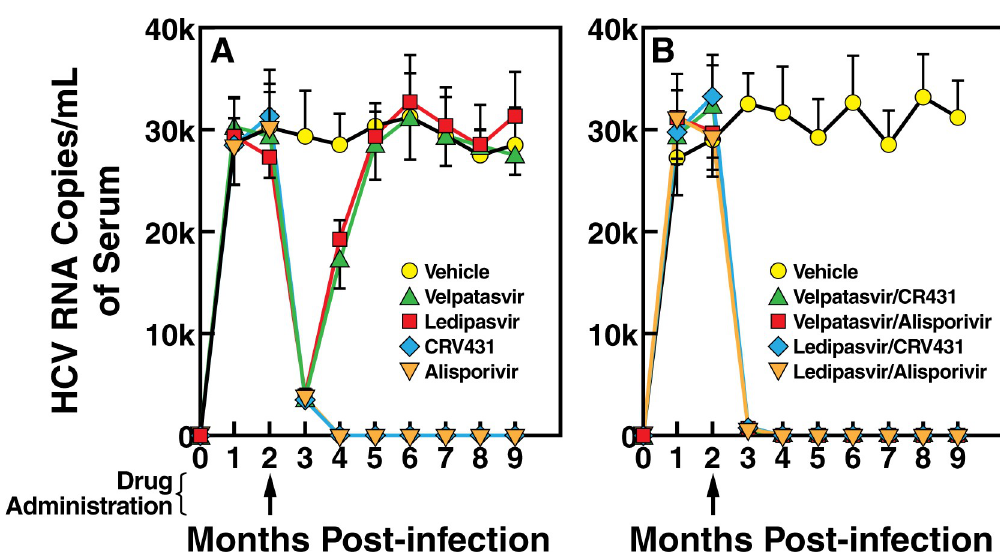
Fig 4. HCV rebound analysis in humanized-liver chimeric mice. MUP-uPA-SCID-Beige mice implanted with human hepatocytes were infected i.v. with plasma from HCV-infected chimpanzee (100 infectious doses (CID 50 )/mL of GT1a, GT2a, GT3a and GT4a). Drugs—Velpatasvir, Ledipasvir, CRV431, Alisporivir—(50 mg/kg) were orally given alone or in combination 2 months post-infection. Ten mice per treatment. Blood was collected until month 9 post-HCV infection. Viral replication (HCV RNA copies/ml of serum) was quantified by real-time reverse transcription PCR. At week 12 and 15 post- infection, SD are small due to the minimal viral loads due to the drug treatment efficacy. Data are representative of two independent